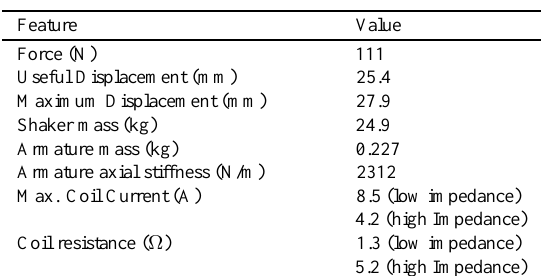
Table 1 MB dynamics shaker